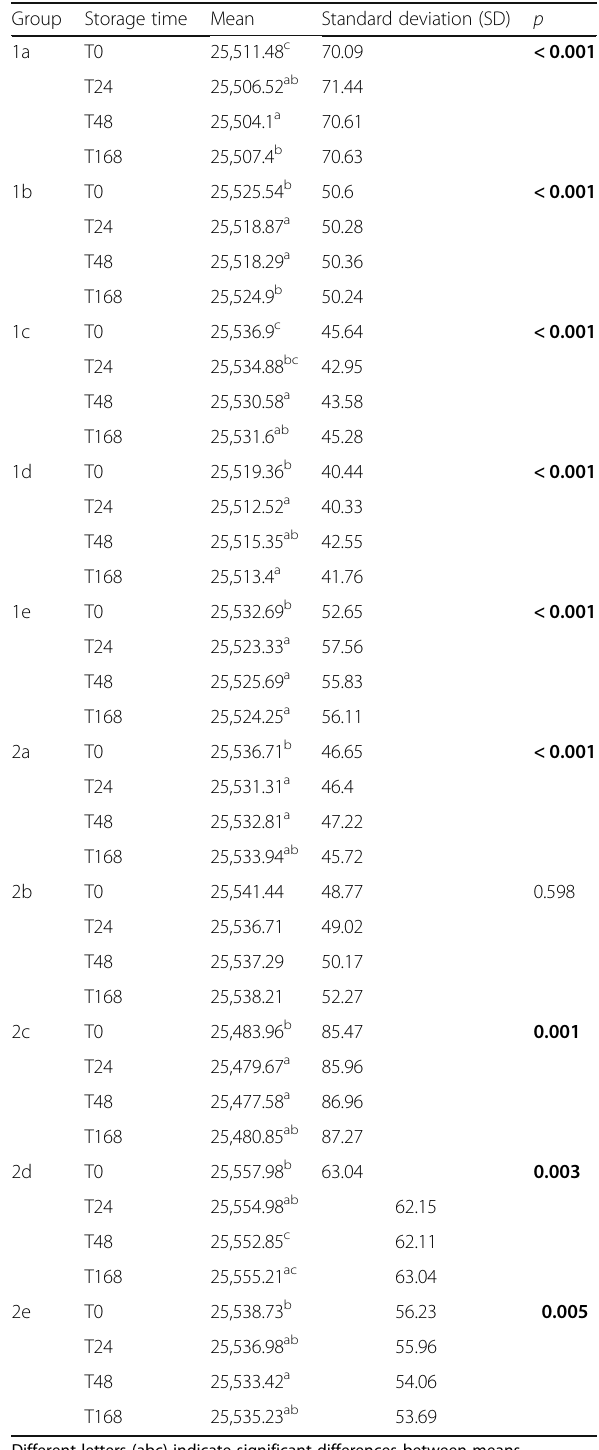
Different letters (abc) indicate significant differences between means (Bonferroni multiple comparison test) Significant level for Repeated measures ANOVA were in